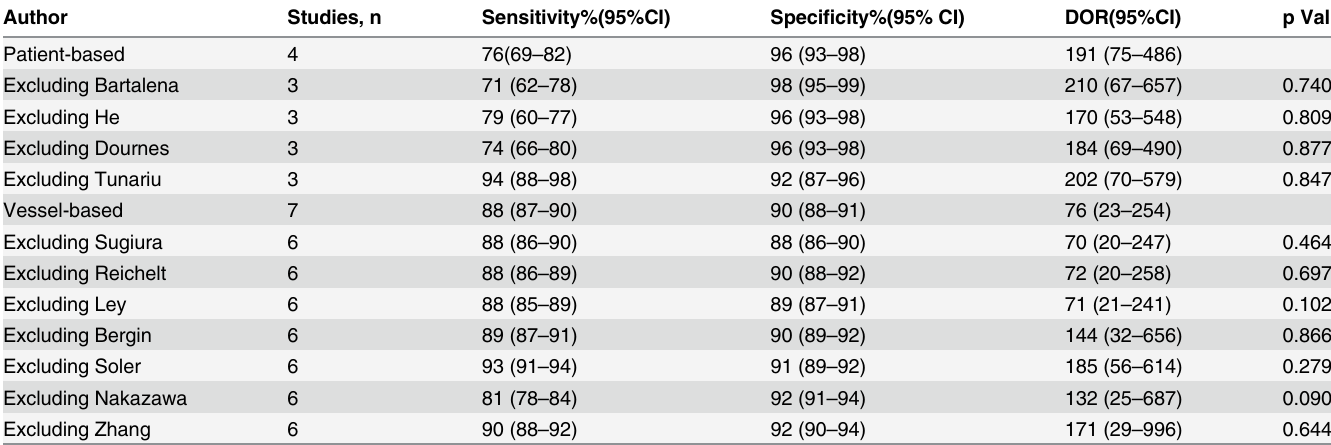
Table 4. Sensitivity analysis on both patient and vessel basis.